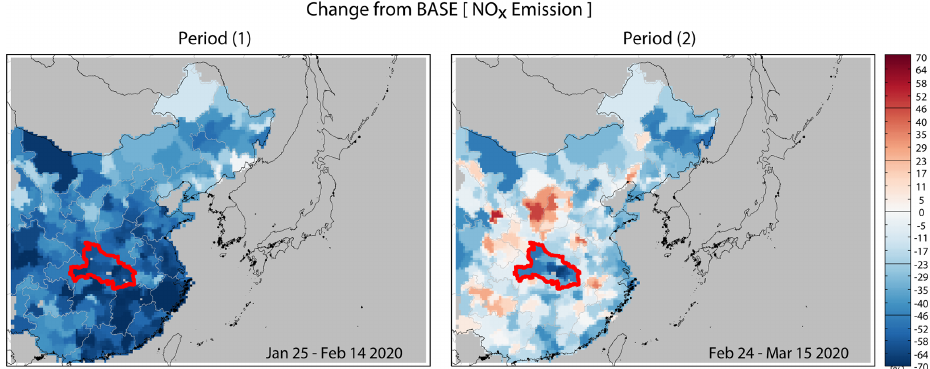
Figure 3. Spatial distribution of the change in estimated NO x emissions from the baseline period (Fig. 2) during the period of